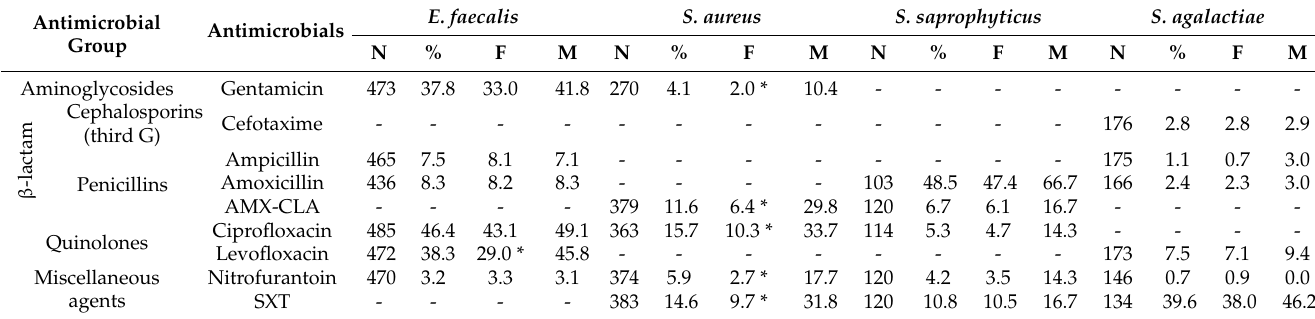
Table 3. Average antimicrobial resistance of the main Gram-positive uropathogens for female and male